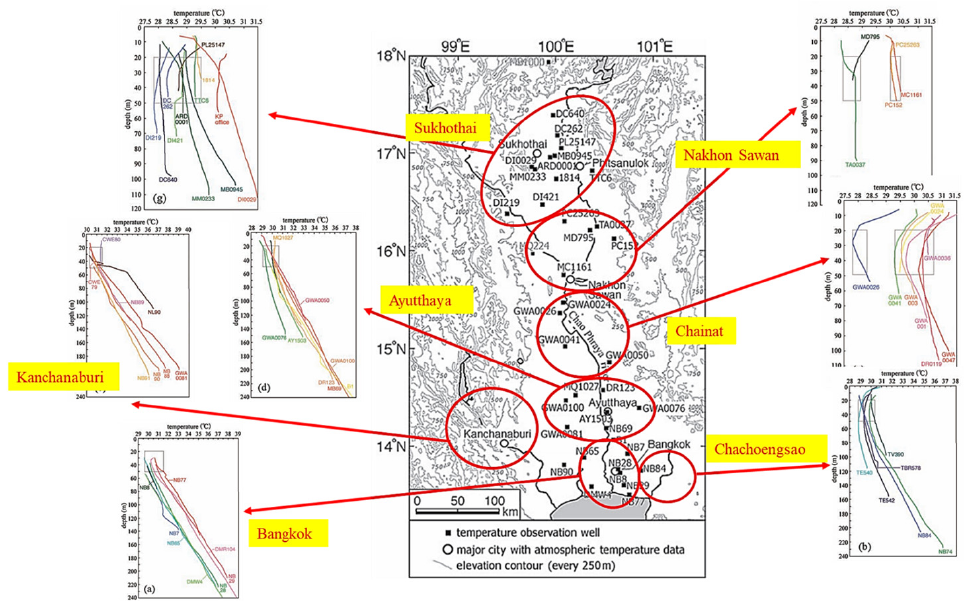
Figure 2. Temperature profiles measured at each observation well around the Chao Phraya Basin (modified based on the report by Yasukawa et al. [40]).